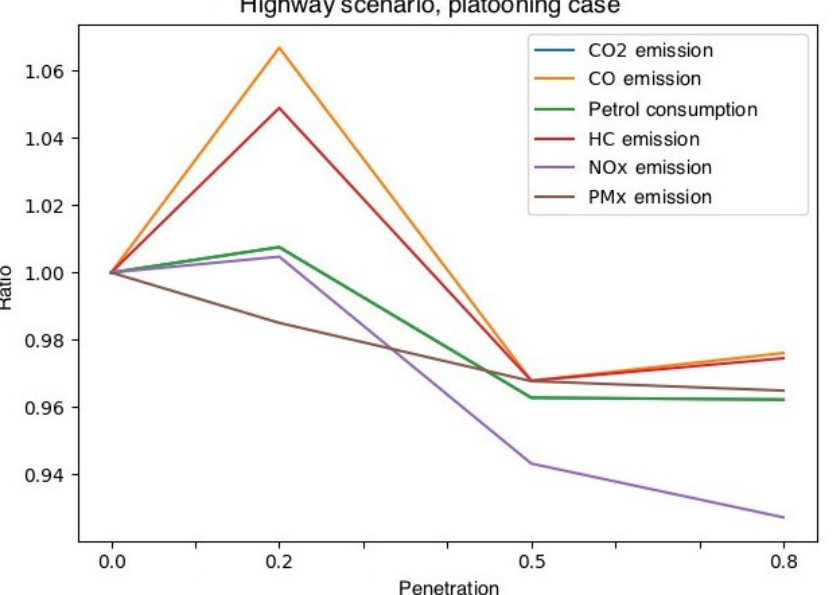
Figure 9. Green gas emission and petrol consumption of highway traffic with platooning service use